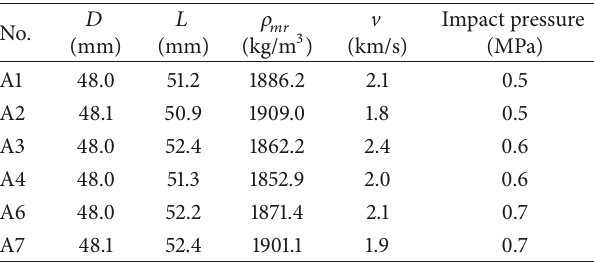
Table 1: Testing results of coal-rock combined body.